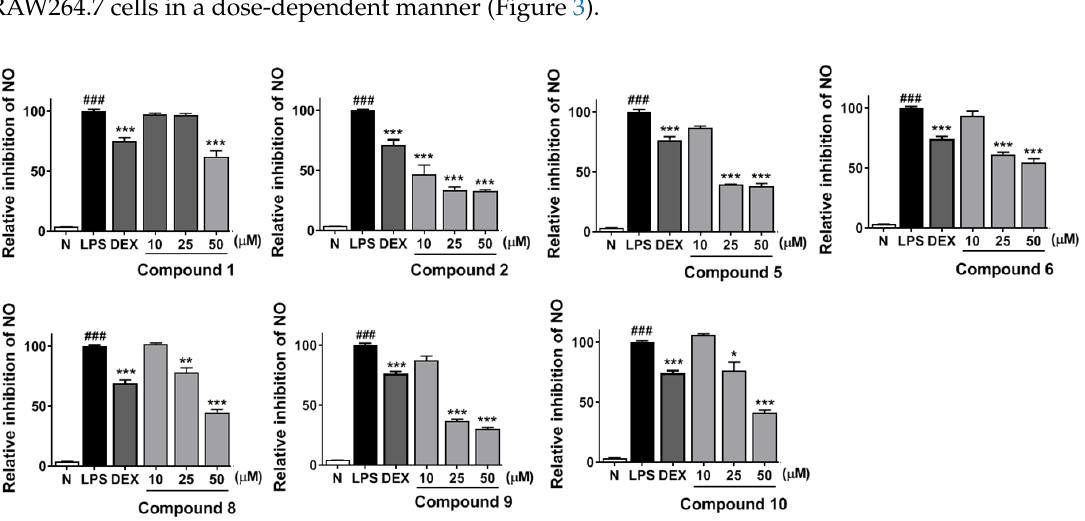
Figure 3. Inhibitory e ff ects of compounds 1 , 2 , 5 , 6 , 8 – 10 at concentrations of 10, 25, and 50 µ M on NO production in RAW 264.7 cells, respectively. Nitrite relative concentration (NRC)—percentage of control group (set as 100%). Values represent the mean ± SD of four determinations. * p < 0.05, ** p < 0.01, *** p < 0.001 vs. LPS group; ### p < 0.001 vs normal group ( N ) Di ff erences between compound-treated group and control group; N = 4.